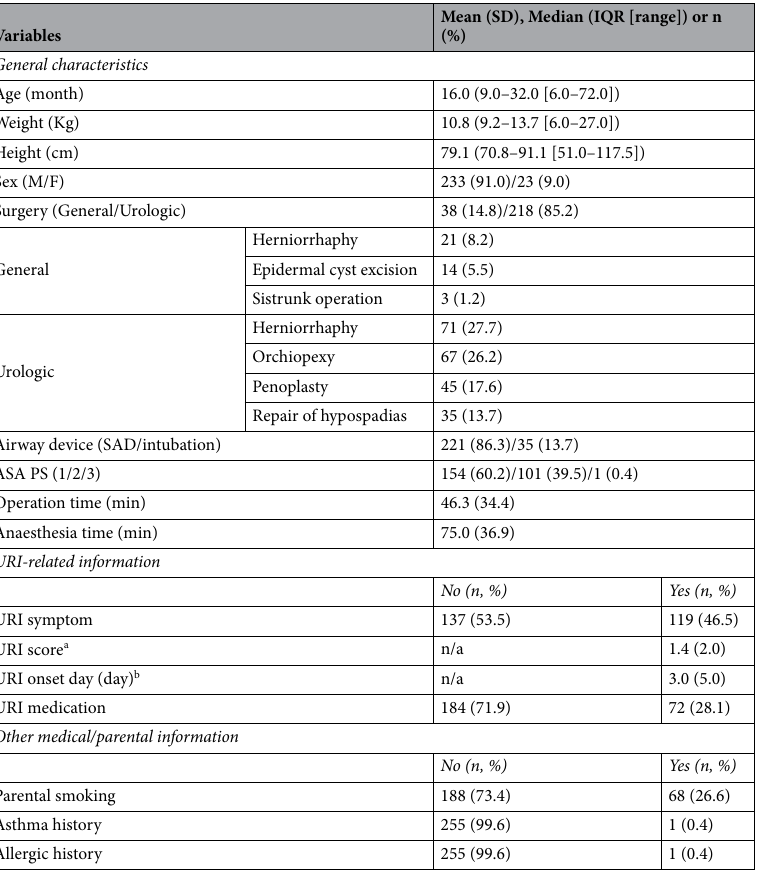
Table 2. Characteristics of children included in the present study. Values are presented as mean (SD), median (IQR [range]) and n (%). M; male, F; female, SAD; supraglottic airway device, ASA PS; American society of anaesthesiologists physical status, URI; upper respiratory infection, n/a; not applicable. a Range of data: from 0 to 24. b Range of data: from 0 to